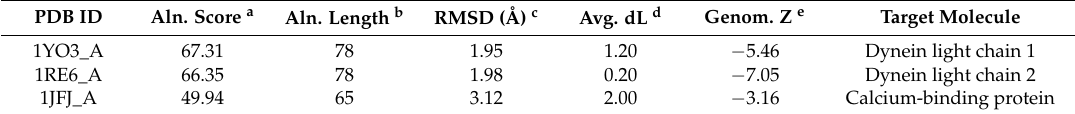
Table 1. Alignment scores of three structures, superimposed using the deconSTRUCT server.